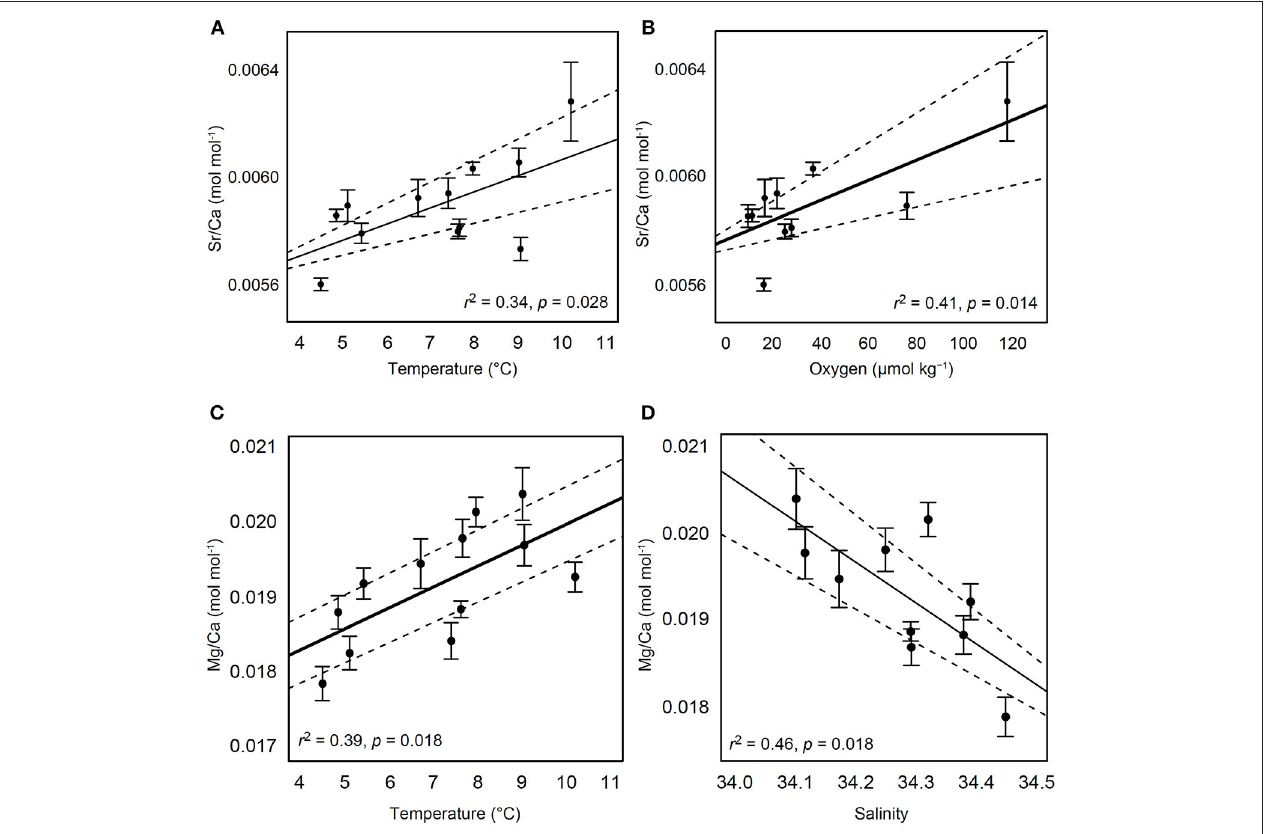
FIGURE 3 | Relationships of test ossicle elemental concentrations and hydrographic variables. Ratios of Sr/Ca (mol mol − 1 ) with (A) temperature and (B) dissolved oxygen. Ratios of Mg/Ca (mol mol − 1 ) with (C) temperature and (D) salinity. Black solid lines indicate the best fit line result of linear regression. Dashed lines indicate 95% confidence intervals. Error bars are ± 1 standard